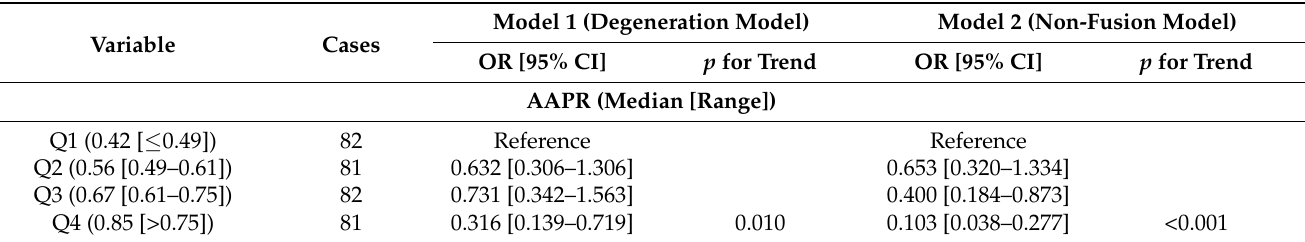
Figure 1. Receiver operating characteristic (ROC) curve to determine the predictive performance of AAPR for severe degeneration ( a ) and non-fusion ( b ). ROC curve analysis of severe degeneration ( c ) and non-fusion models ( d ) (see Tables 5 and 7 for included variables). Table 6. Association of severe degeneration and non-fusion with